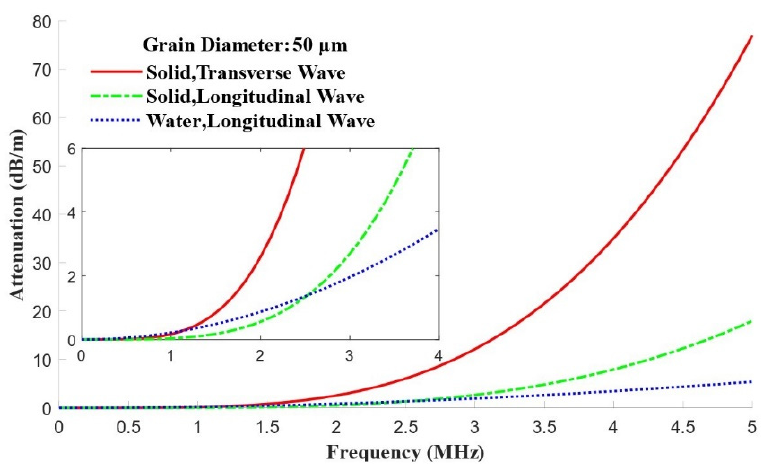
Figure 5. Attenuation coefficients in the frequency